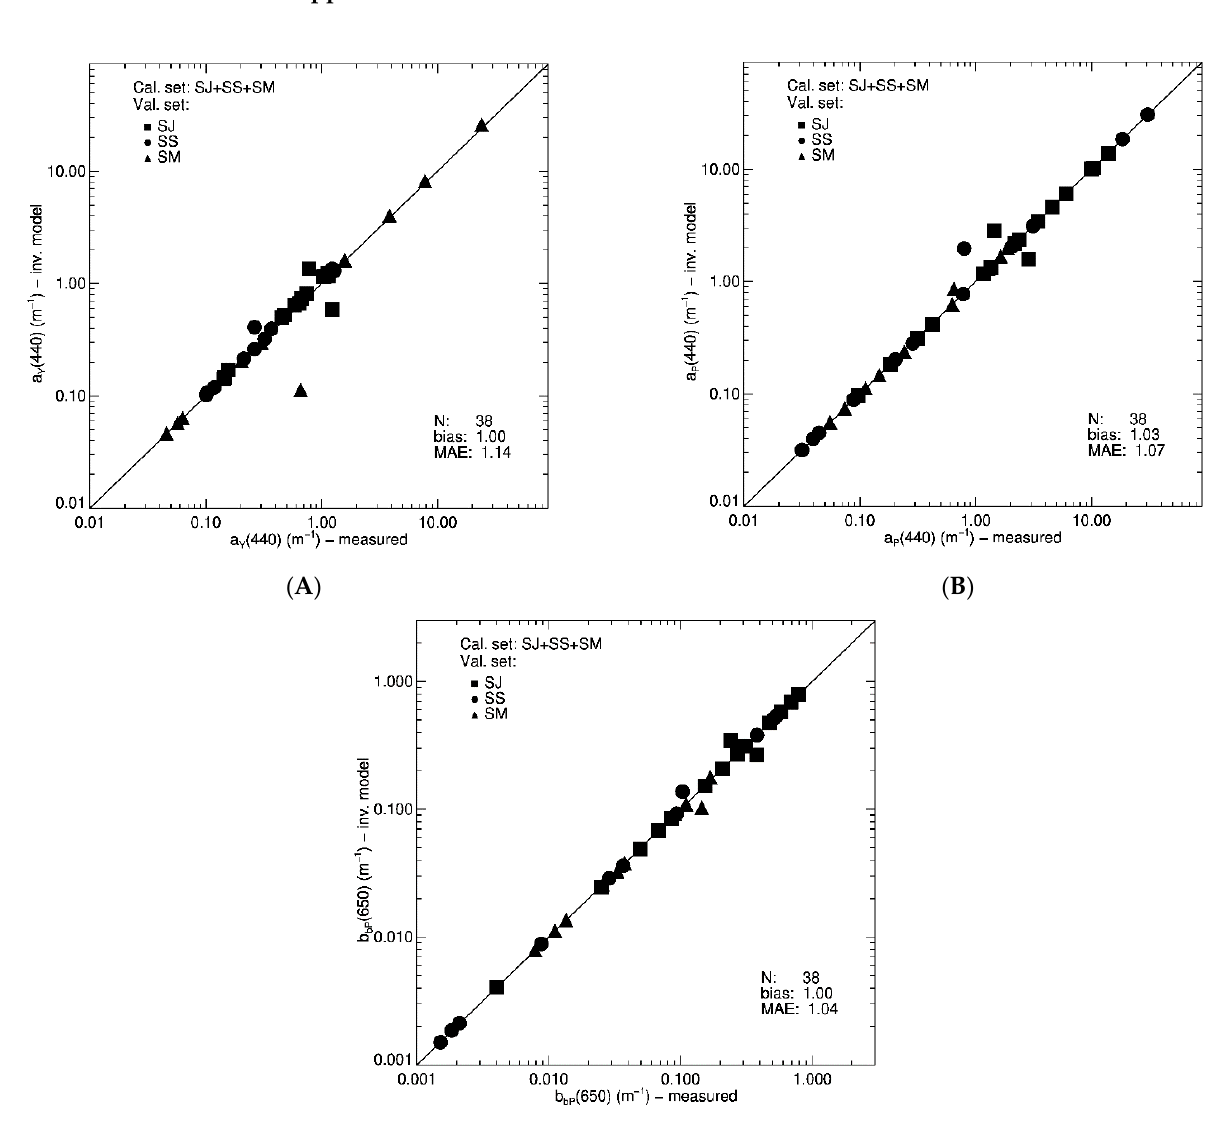
Figure A1. Retrieval of inherent optical properties using iSAM model and the full set of the Sarawak spectral optical library, ( A ) aY(440), ( B ) aP(440) and ( C ) bbP(650).